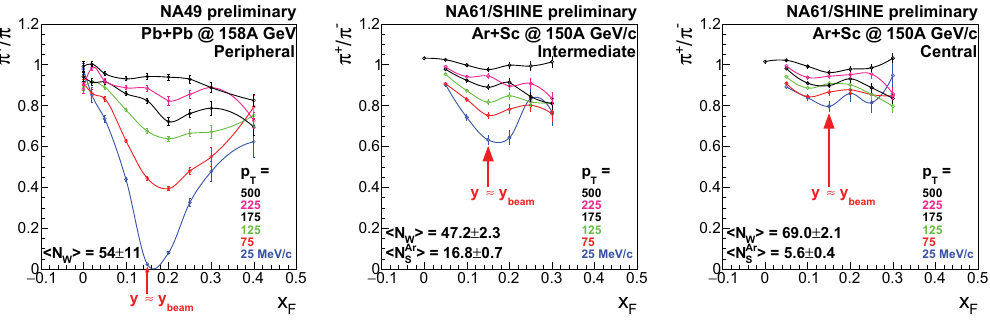
Figure 7: The π + /π − ratio as a function of x F for several values of transverse momentum in peripheral Pb + Pb [30], intermediate centrality Ar + Sc and central Ar + Sc collisions at the top CERN SPS beam momentum. Only statistical uncertainties are